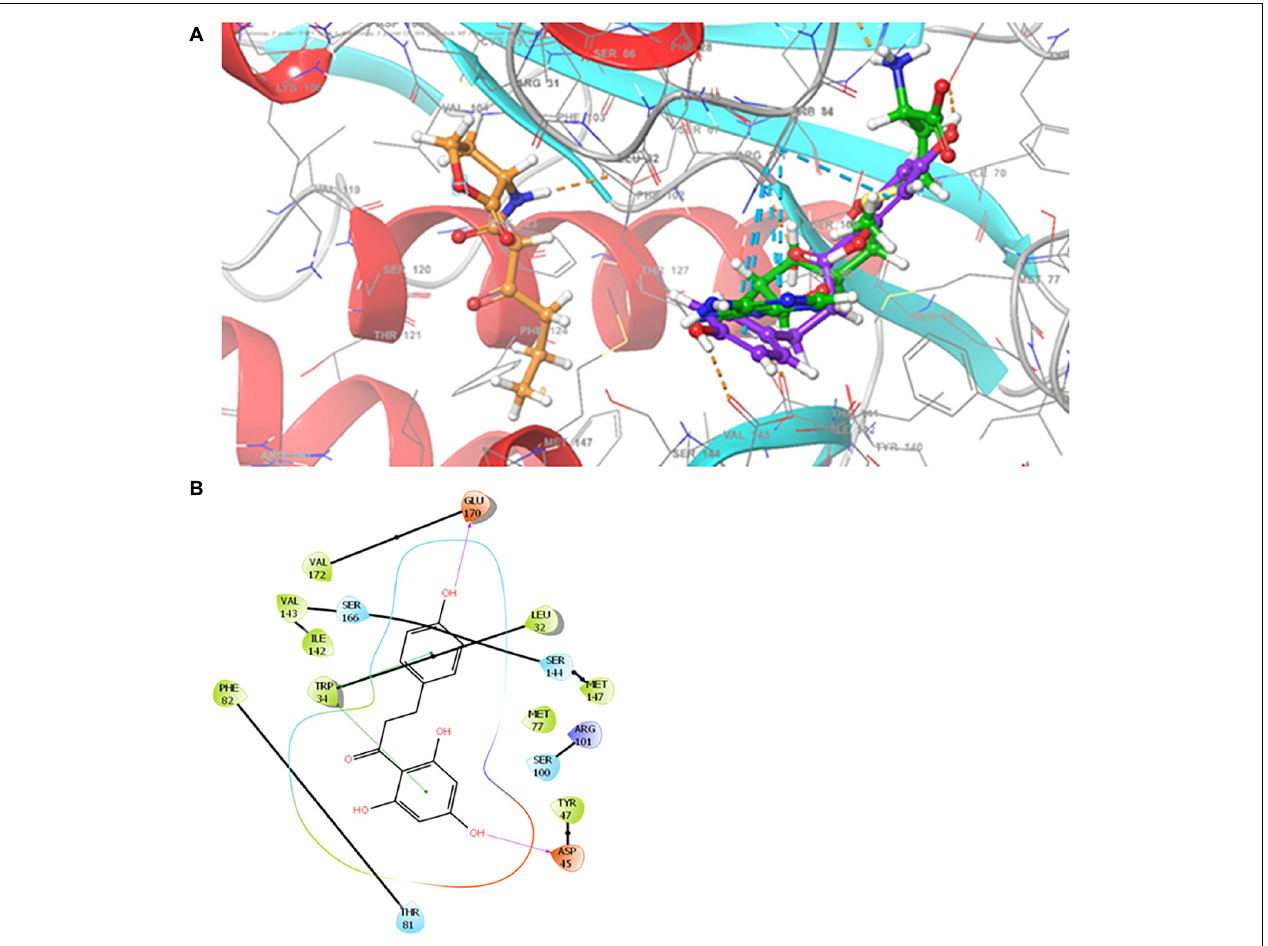
FIGURE 8 | (A) Superimposition of 3-oxo-C 6 -HSL, SAM and phloretin. Binding modes for 3-oxo-C 6 -HSL, SAM and phloretin were determined by Glide XP at the binding site of ExpI. Carbon atoms of 3-oxo-C 6 -HSL, SAM and phloretin are colored orange, green and violet, respectively. Hydrogen bonds are presented as orange dashed lines and π − π stacking is shown as cyan dashed lines. (B) Two dimensional (2D) presentation of the interactions of phloretin in the binding site of ExpI (within 4 Å from the docked compound). Red, purple, cyan and green spheres represent positively charged, negatively charged, polar and hydrophobic residues respectively. Hydrogen bonds are presented as pink arrows and π − π stacking is shown as green